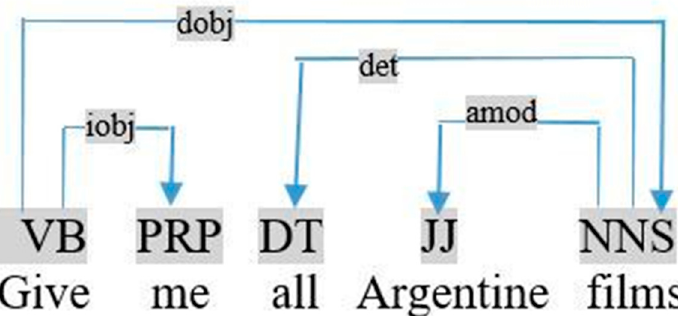
Figure 9. Graph dependency of the query «who created English Wikipedia».